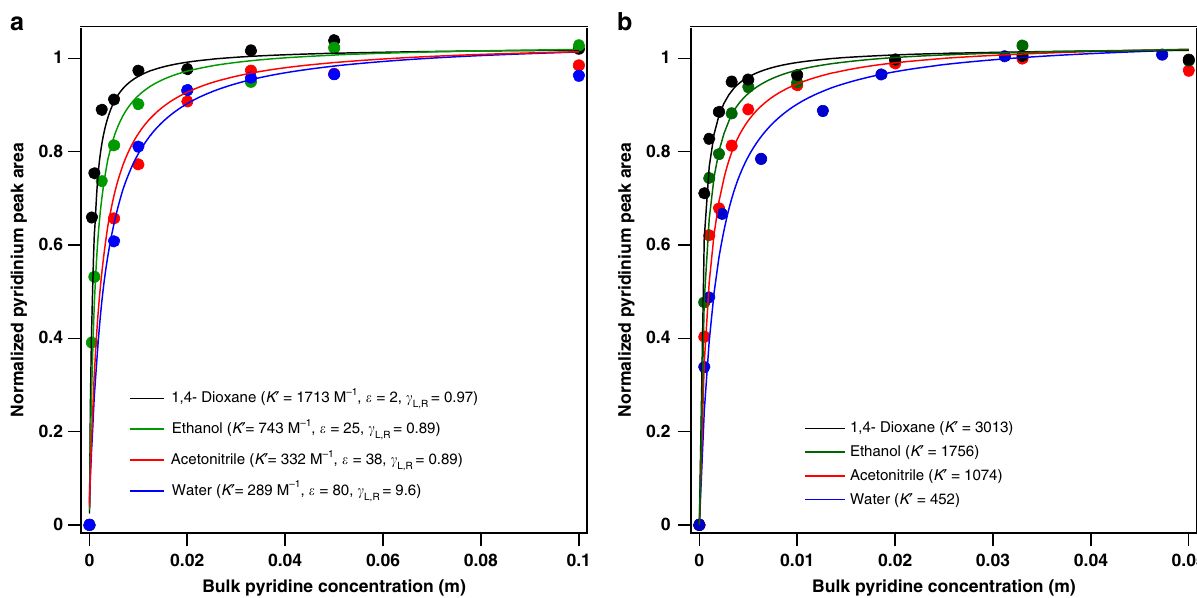
Fig. 4 Normalized pyridine isotherms in various solvents on aluminosilicate zeolites. a Pyridine adsorption isotherms onto H/Y BAS (Si/Al = 3) and b H/Beta (Si/Al = 12) in various solvents at 20 °C. Dielectric constants ( ε ), activity coef fi cients ( γ ), and Langmuir parameters ( K ′ ) listed in